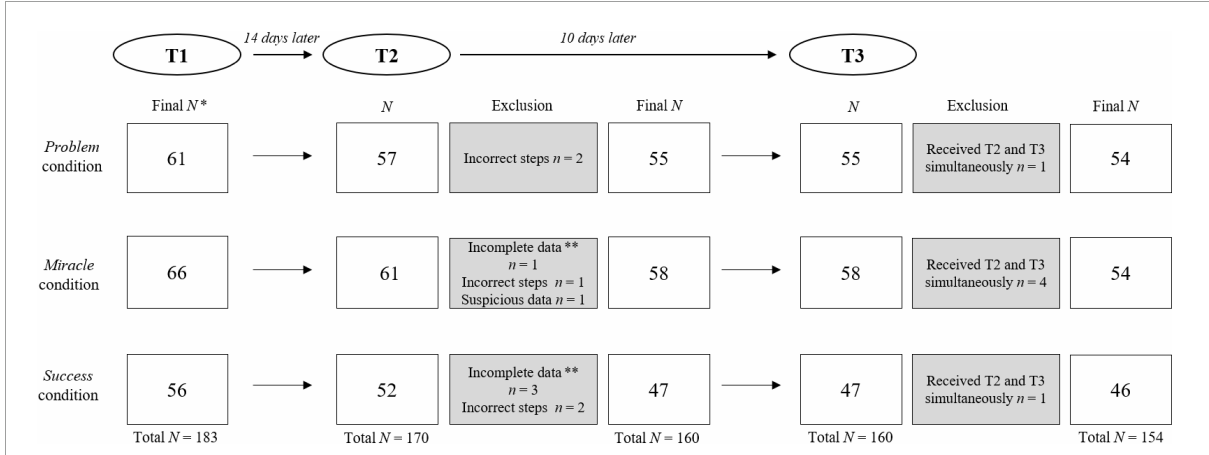
FIGURE2 CONSORT flowchart depicting screening and exclusion procedure for T2 and T3 Follow-up. The sample at T1 consisted of 183 participants allocated to one of the three experimental conditions. Of the 183 participants, 1 participant did not indicate their email address and thus did not receive the T2 survey. Of the remaining 182 participants, 170 participants (response rate: 92.9%) filled in the T2 survey. Overall, 10 participants were excluded as they did not complete the survey, indicated that the steps reported were not correct or showed suspicious data entry. The final sample at T2 consisted of 160 participants. The final T3 sample that was analyzed consisted of 154 participants. 6 participants were excluded as they received the link for the website (T3) and the T2 survey simultaneously and this could potentially distort the answers on the T2